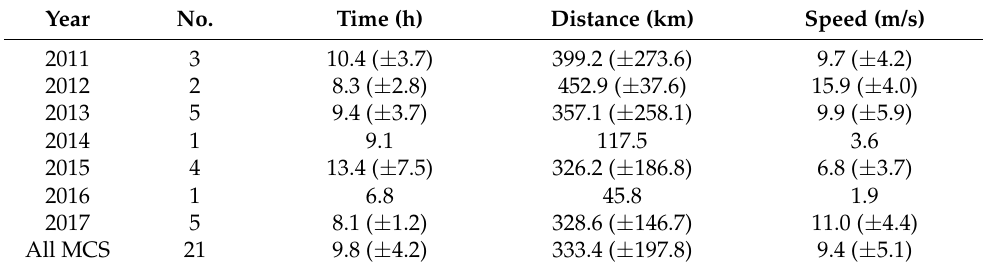
Table 5. As in Table 4, but MCS propagating southward.